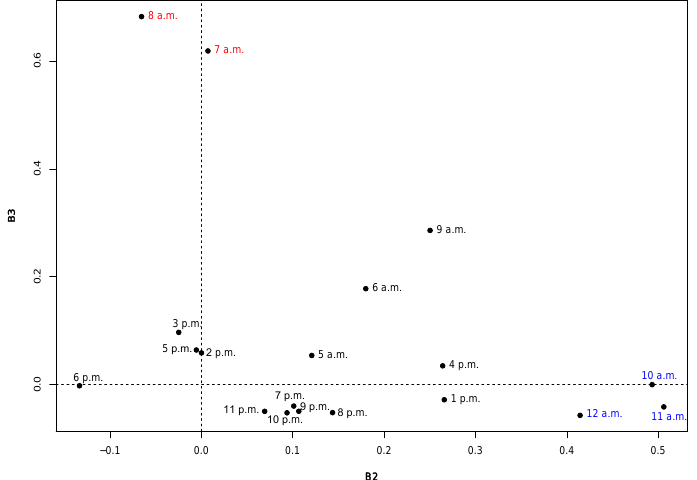
Figure 9. Loading plots (principal coordinates) for mode 2 (Timetable). Component 2 vs. Component 3 for mode 2.